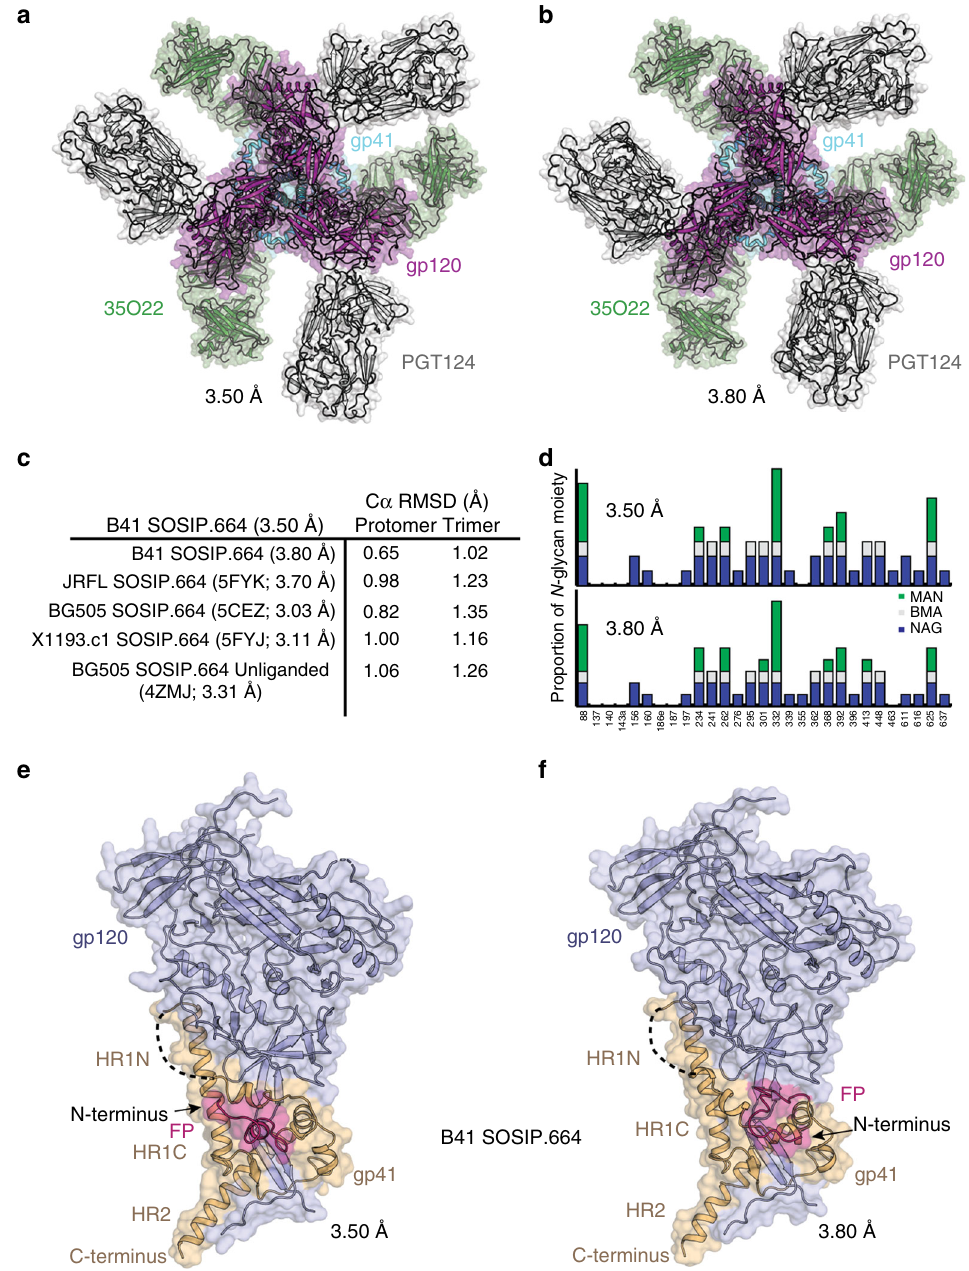
Fig. 1 Crystal structures of closed prefusion structure of B41 SOSIP.664 Env trimer. a , b Views of the Fab complex down the trimer axis with gp120 in pink and gp41 in cyan. The cartoon representation is overlaid with a transparent molecular surface. Fabs PGT124 (dark gray) and 35O22 (green) are from the 3.50 and 3.80 Å structures in space groups P23 ( a ) and P6 3 ( b ), respectively. c Comparison of the protomer/trimer backbones from crystal structures of trimers of clade A (BG505 SOSIP.664, bound and unbound), B (JRFL SOSIP.664), G (X1193.c1 SOSIP.664), and the new B41 SOSIP.664 structure at 3.50 Å. d Glycosylation observed in the electron density maps in the two different B41 SOSIP.664 crystal structures. The blue, gray, and green bars along the Y -axis represent the number of N -glycan moieties of N -acetylglucosamine (NAG/GlcNAc) (maximum possible, two), β - D -mannopyranose (BMA) (maximum, one), and α - D -mannopyranose (MAN) (maximum, eight), respectively. The X -axis represents N-glycosylation sites on B41 SOSIP.664. e , f Side views of B41 SOSIP.664 protomer (gp120: light blue, gp41: light orange) in cartoon representation, overlaid with a transparent molecular surface showing two conformational states of the free N-terminus FP (pink) going away from (3.50 Å) and towards (3.80 Å) the C-terminus (i.e. proximal to the